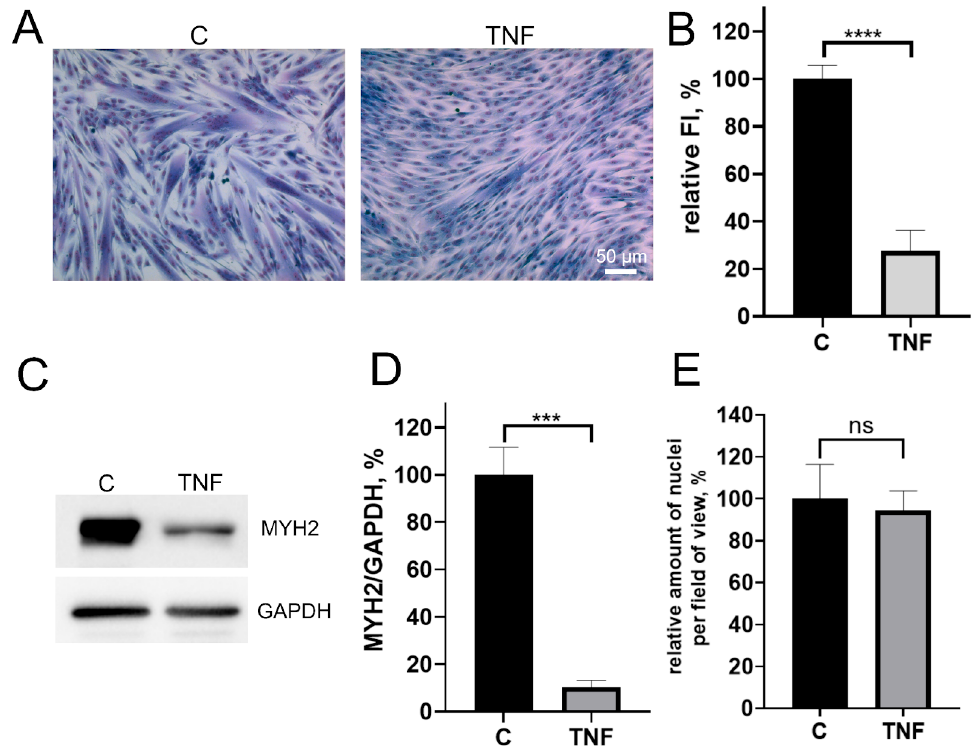
Figure 1. TNF impairs myogenic differentiation of MB135 myoblasts. Cells were treated with 50 ng/mL TNF 24 h before the induction of differentiation. Differentiation was analyzed on day 3 after induction. ( A ) Myotubes were visualized by May–Grunwald staining. Representative images are shown, scale bar: 50 μ m. ( B ) Fusion index (FI) was calculated by dividing the number of nuclei inside the myotubes by the total number of nuclei for each sample and FI in the control sample (c) was taken as 100%. ( C ) Representative Western blot showing MYH2 expression. ( D ) Densitometric analysis of Western blots for MYH2 expression in the control and TNF-treated myoblasts. ( E ) Number of myoblast/myotubes nuclei in the control and TNF-treated cultures per field of view. Data are presented as % relative to the untreated control (mean ± SD, ***— p < 0.001, ****— p < 0.0001, n ≥ 3, ns: no significant difference).